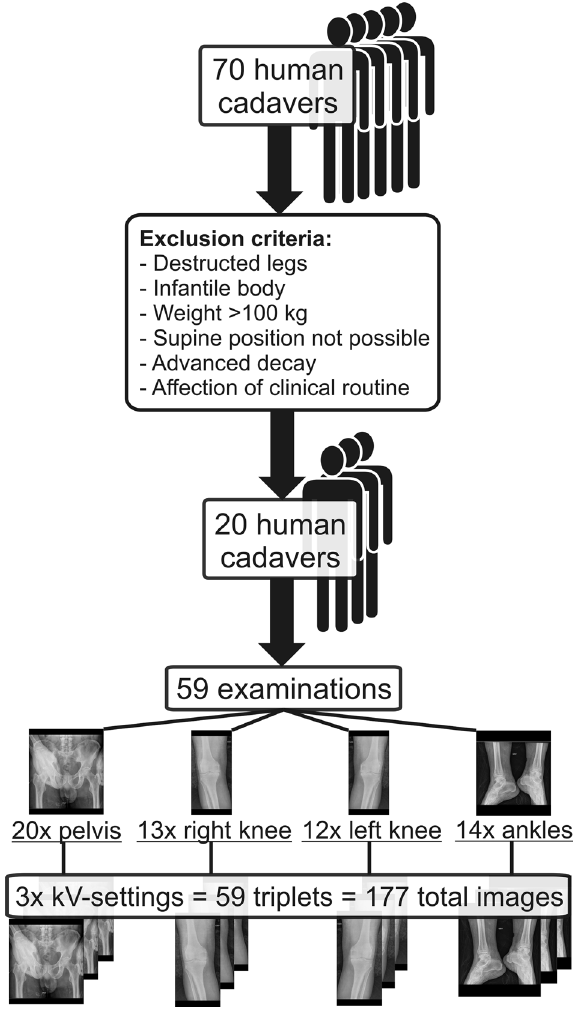
Figure 2. Study population selection process. From 70 human cadavers receiving post-mortem CT examination, a total of 20 human cadavers were referred to digital radiography. 59 examinations with a triplet of 3 kV-settings were performed including 20 pelvis, 13 right knees, 12 left knees and 14 ankles, resulting in a total number of 177 radiographs.